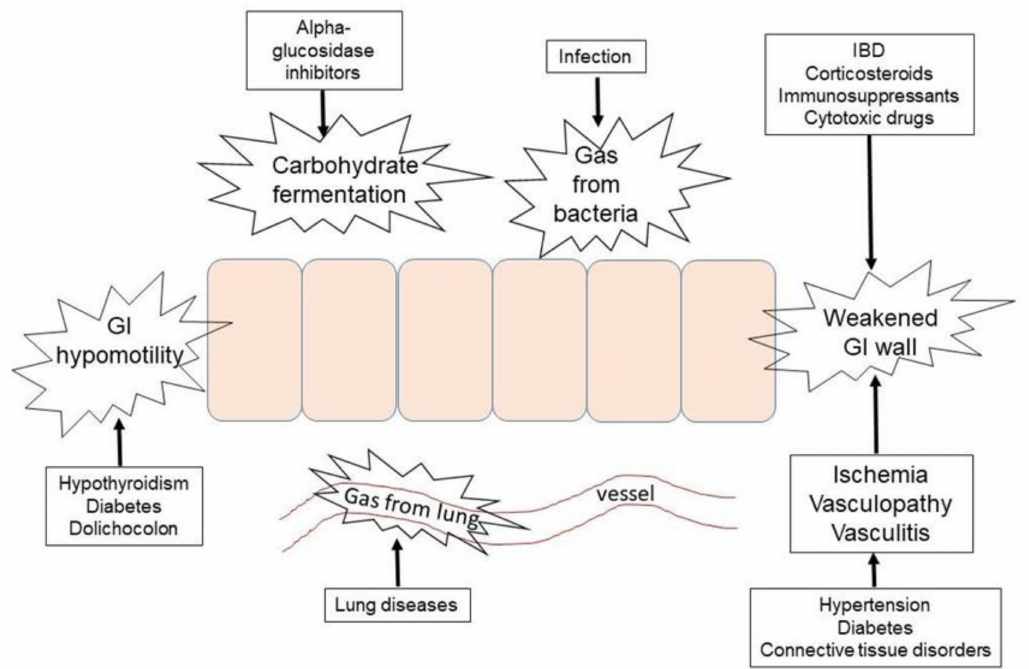
Figure 3. Possible mechanisms of α GIs-induced PI. Legend: There are multiple contributors to the development of α GIs-induced PI: increased production of intestinal gas, hypomotility of the gastrointestinal tract, weakened intestinal mucosa and wall, and/or air carried from the lungs. Abbreviations: IBD: inflammatory bowel disease; GI: the gastrointestinal